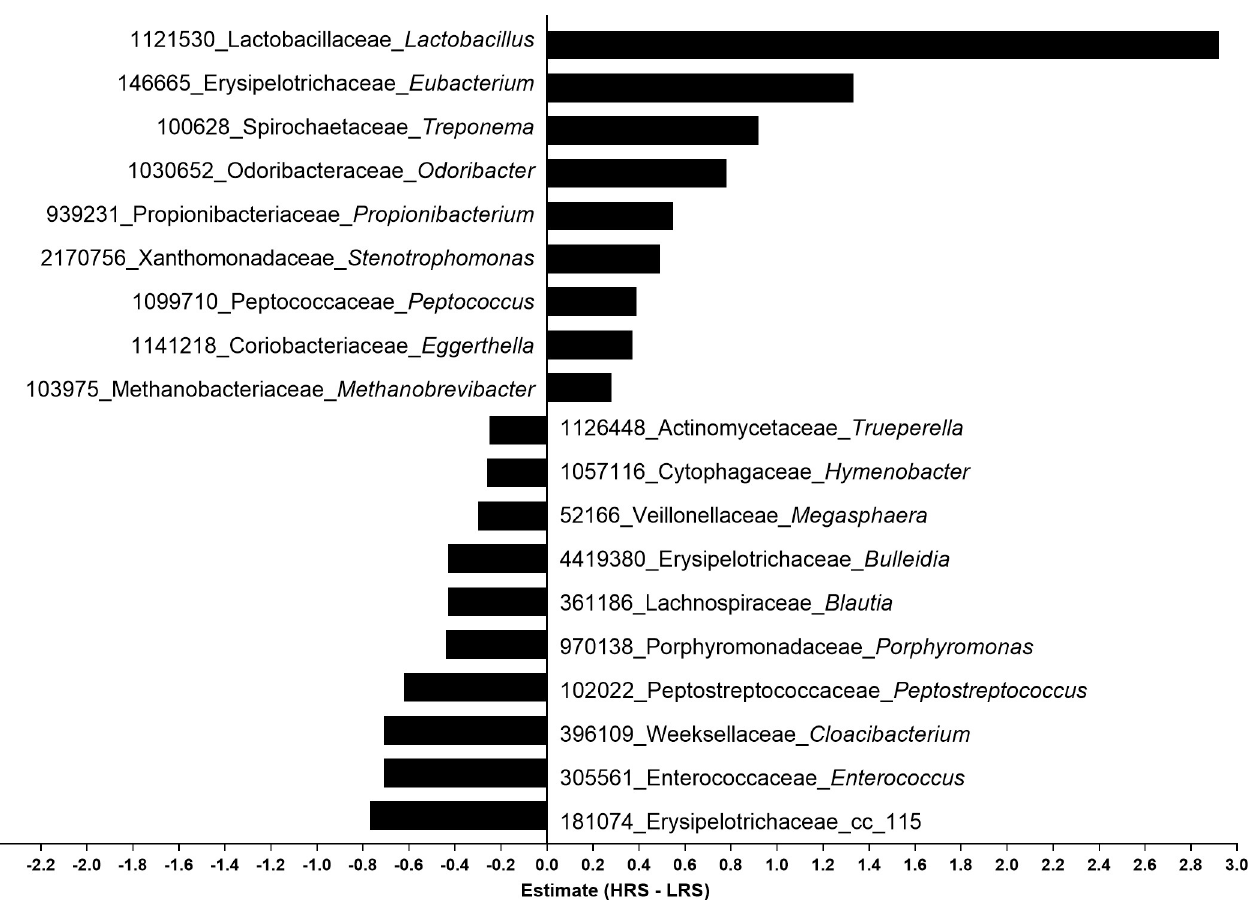
Fig 2. Significant genus-level taxa differences in the fecal microbiome from consumption of HRS or LRS food using a mixed model of weeks 3 and 6. Subject and collection number were random factors. Operational taxonomic unit number, family, and genus are shown for those with the greatest differences; full data are available in S3 Table. HRS, high resistant starch; LRS, low resistant starch.